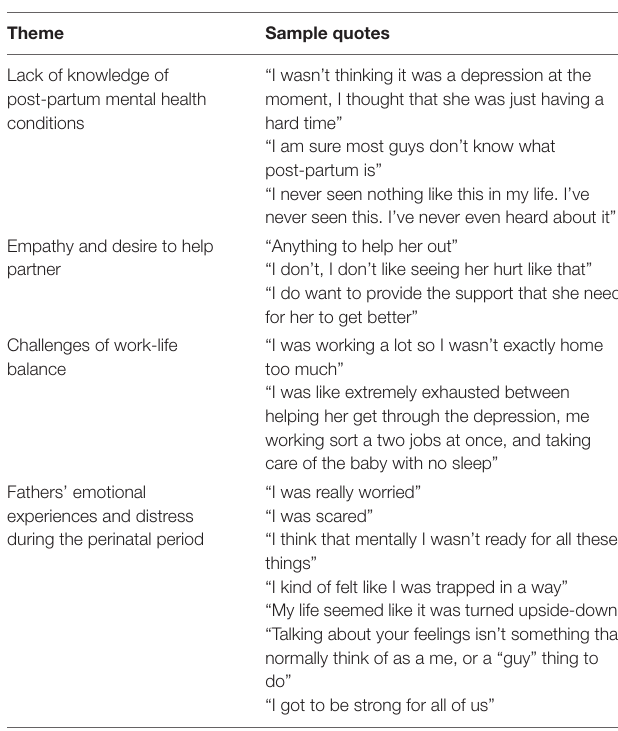
TABLE 1 | Participant demographic and clinical characteristics. TABLE 2 | Qualitative themes and representative quotes. Topic area 1: Fathers’ experiences during the postpartum